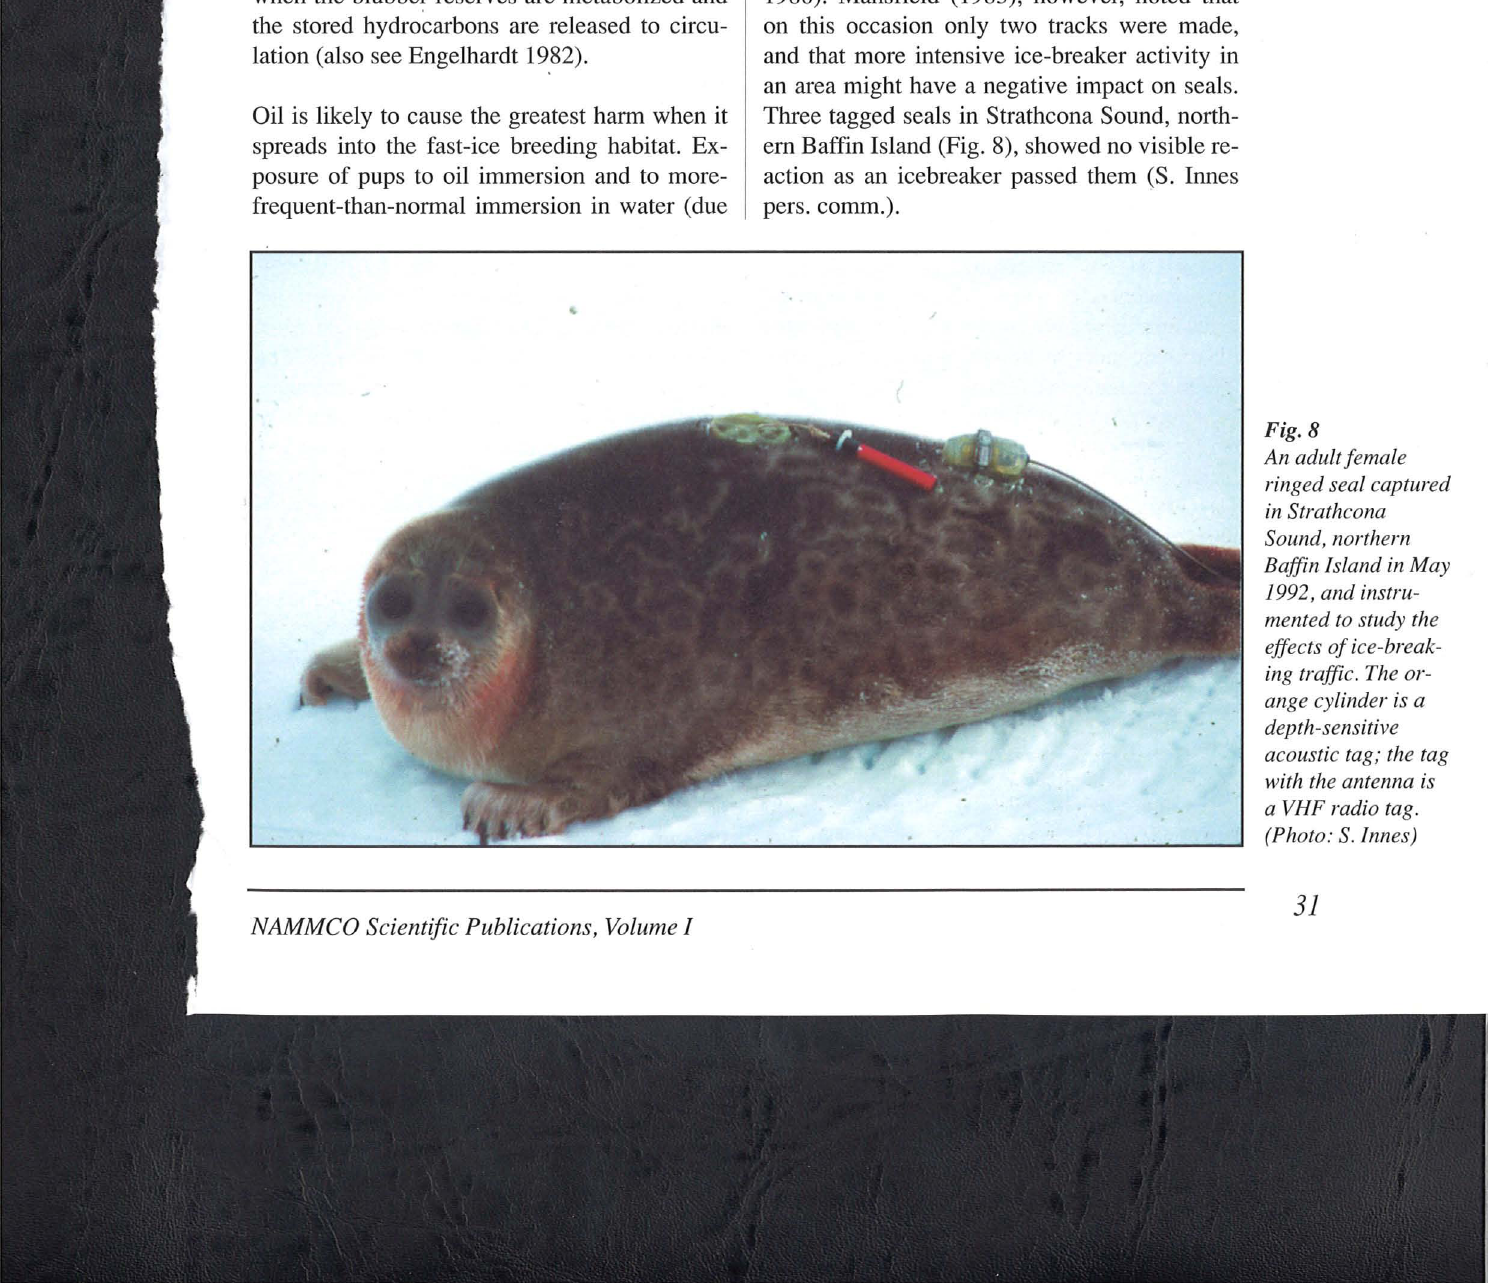
Fig. 8 An adult female ringed seal captured in Strathcona Sound, northern Baffin Island in May 1992, and instru mented to study the effects of ice-break ing traffic. The or ange cylinder is a depth-sensitive acoustic tag; the tag with the antenna is a VHF radio tag. (Photo: S. Innes)